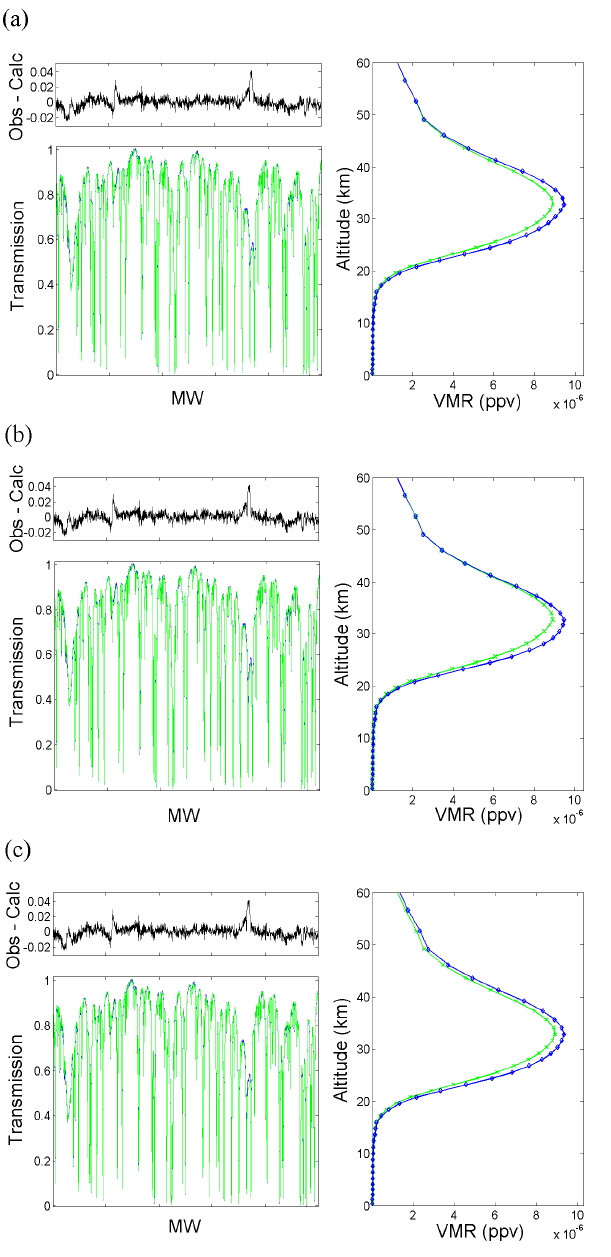
plus interfering 3 Figure 4. Averaging kernels and sensitivity curve (black dashed) for the O retrieval 3 Fig. 4. Averaging kernels and sensitivity curve (black dashed) for the O 3 retrieval from a single spectrum on 12 September 2007 at from a single spectrum on September 12, 2007 at St.-Denis using the (a) OEM, (b) IOA St.-Denis using the (a) OEM, (b) IOA and (c) and (c) TR.